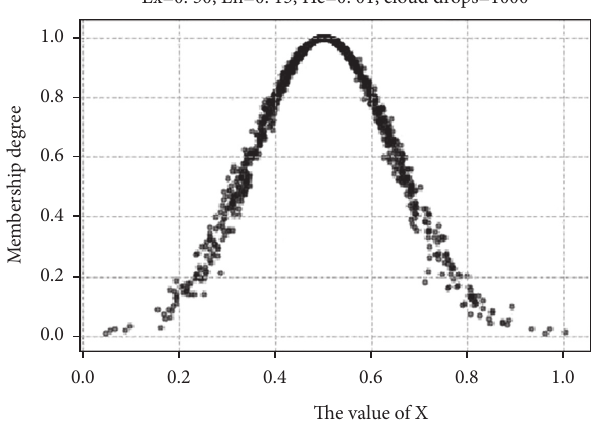
Figure 2: Digital features of normal